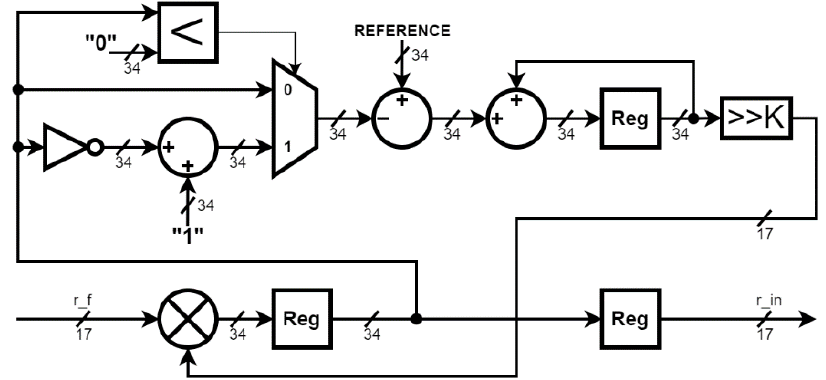
Figure 16. Automatic gain control unit structure.